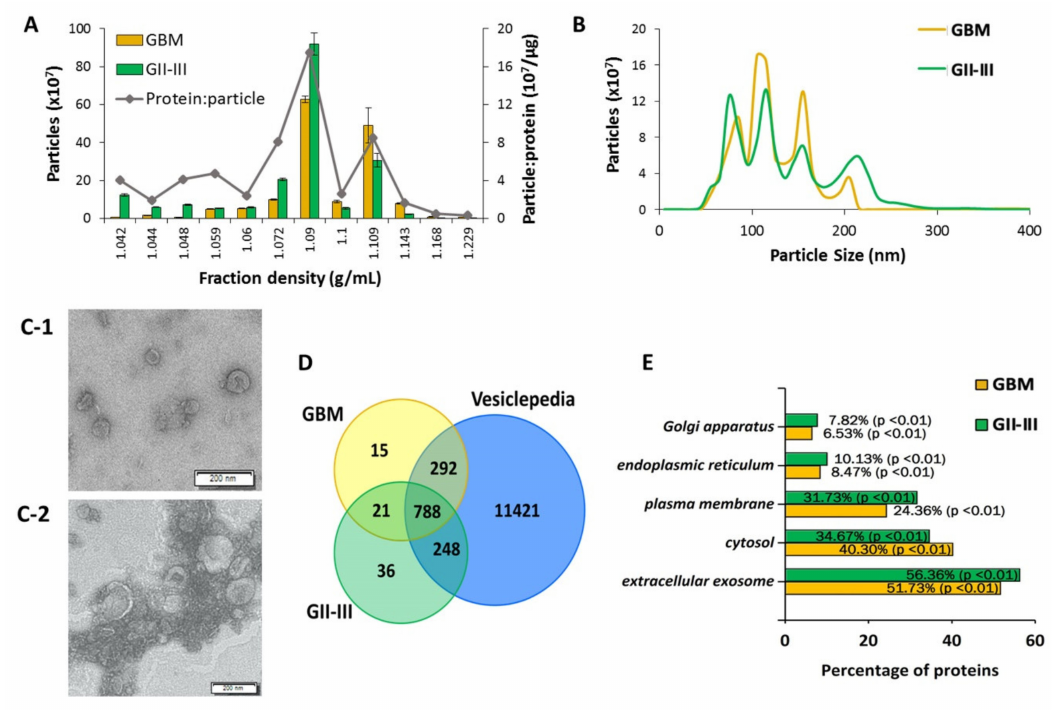
Figure 1. Characterization of extracellular vesicles (EVs) isolated from glioblastoma (GBM) and astrocytoma GII-III surgical aspirates. EVs isolated from cavitron ultrasonic surgical aspirate (CUSA) washings from astrocytoma II-IV patients were enriched on OptiPrep TM density gradients. Nanoparticle tracking determined ( A ) particle numbers measured in each of the 12 density fractions collected (error bars indicate the standard error of the mean) and average particle to protein ratio and ( B ) size distributions of enriched GBM and GII-III CUSA-EVs in combined fractions 7–9. ( C-1 ) Transmission electron microscopy (TEM) was used to visualize enriched CUSA-EVs from GBM and ( C-2 ) astrocytoma grade II surgeries, scale bar = 200 nm. ( D ) Overlap of liquid chromatography tandem mass spectrometry (LC-MS / MS) sequenced proteins confidently identified in at least 80% of GBM (yellow) and GII-III (green) CUSA-EVs with proteins listed in Vesiclepedia (blue) associated with ‘extracellular vesicle,’ ‘exosome,’ ‘microparticle’ and ‘microvesicle.’ ( E ) FunRich annotations of GBM and GII-III CUSA-EV proteins to cellular